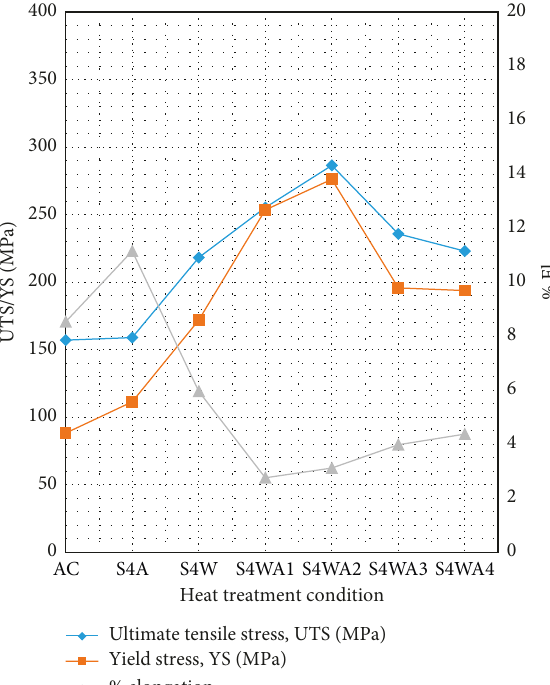
Figure 2: Average values of UTS, YS, %El for alloy B in the as-cast condition and after heat treatments comprising SHTfor 4h (tested at 250 °